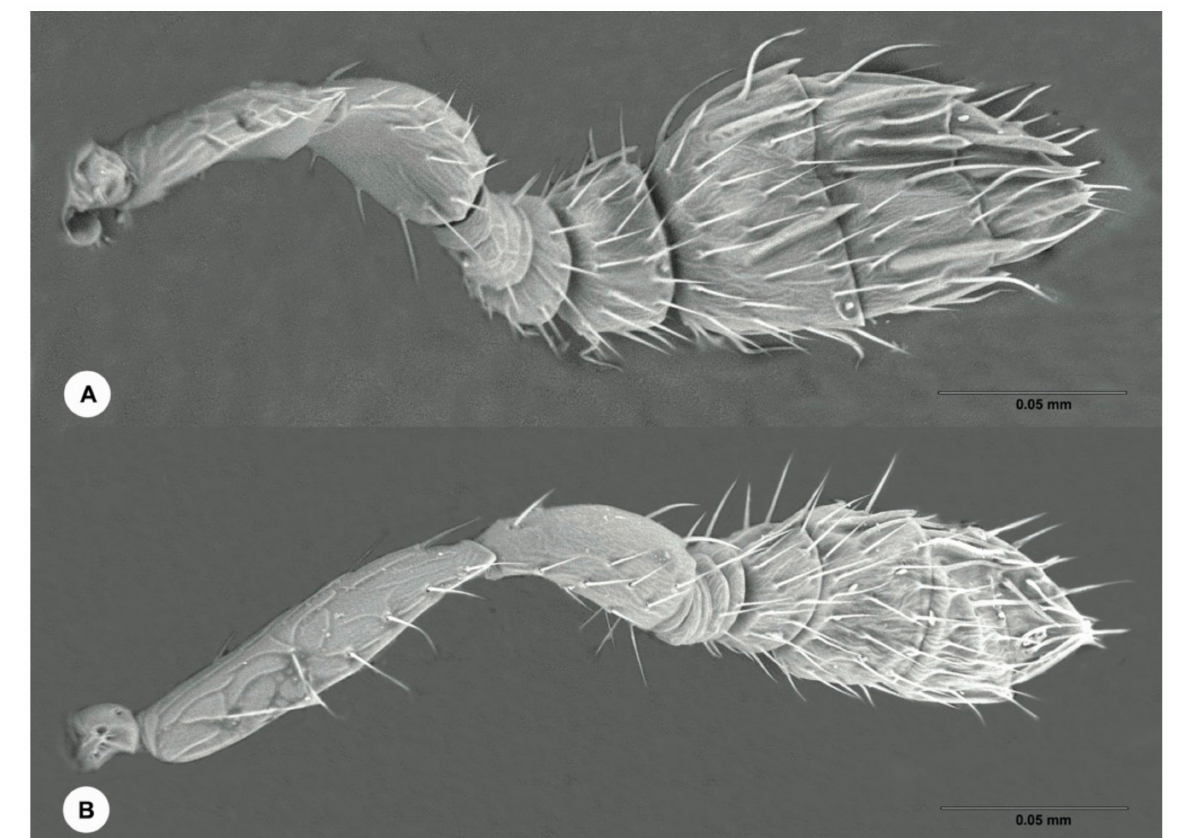
Figure 7. Ophelimus bipolaris sp. n. Antenna ( A ) Female ( B )